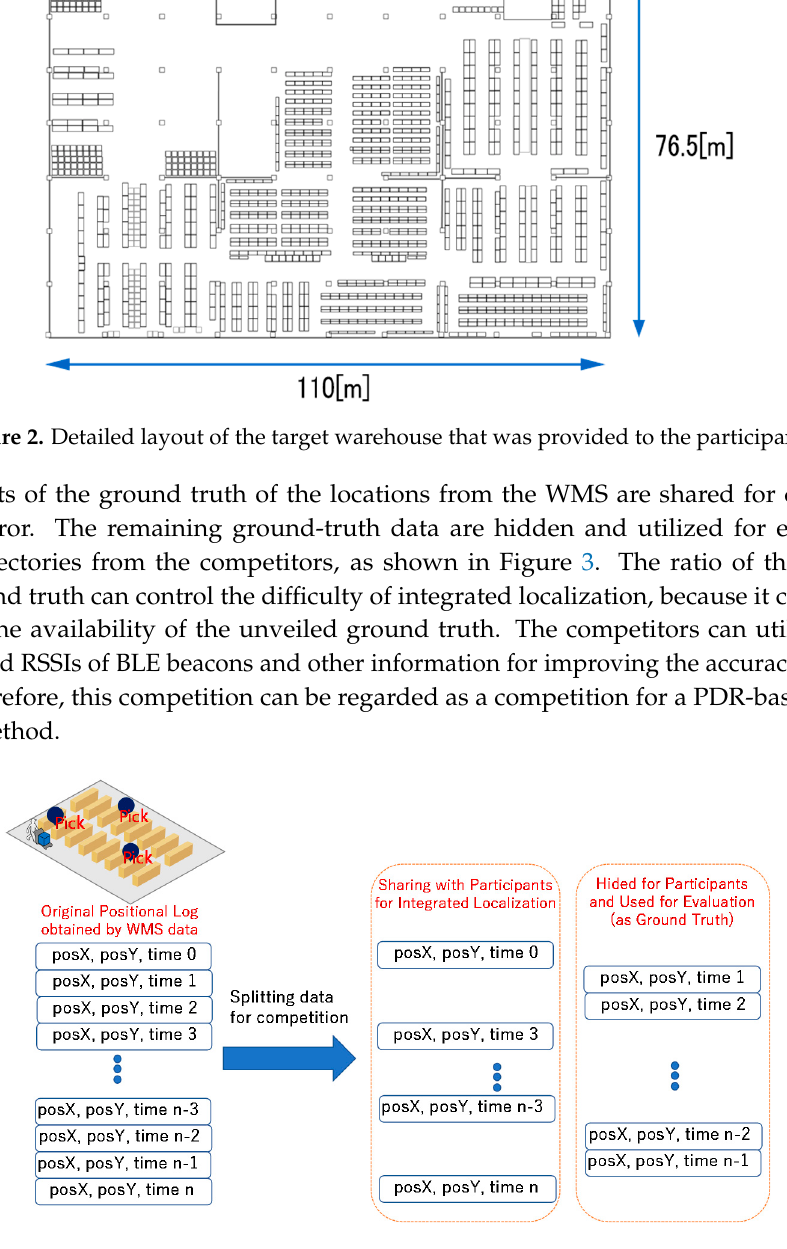
Figure 3. Positional logs extracted by warehouse management system (WMS) data are separated into two parts. One part is shared with the participants, who are supposed to use them for canceling the error in integrated localization. The other part is hidden for participants, and the organizer uses it as the ground truth for position